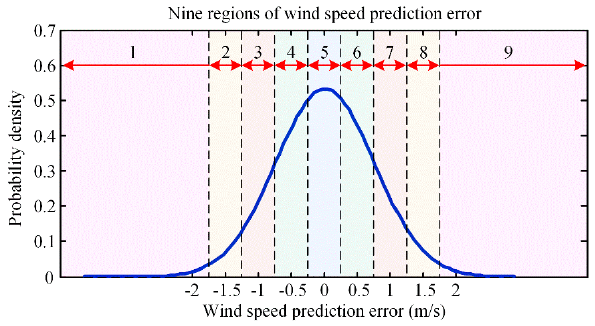
Figure 5. Nine regions of wind speed prediction errors. Table 2. The probability for each discrete wind speed prediction error.